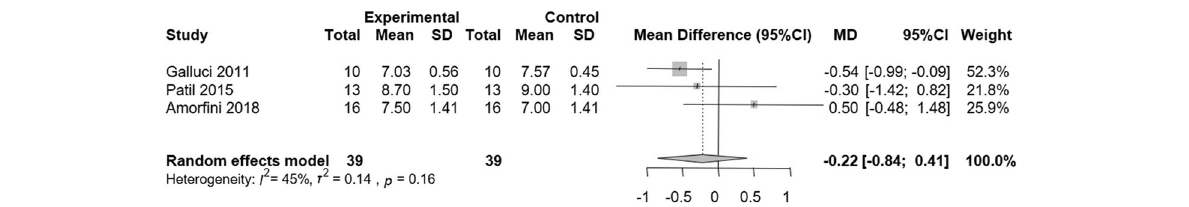
Fig. 2 Forest plot of the overall mean difference in PES between experimental and control